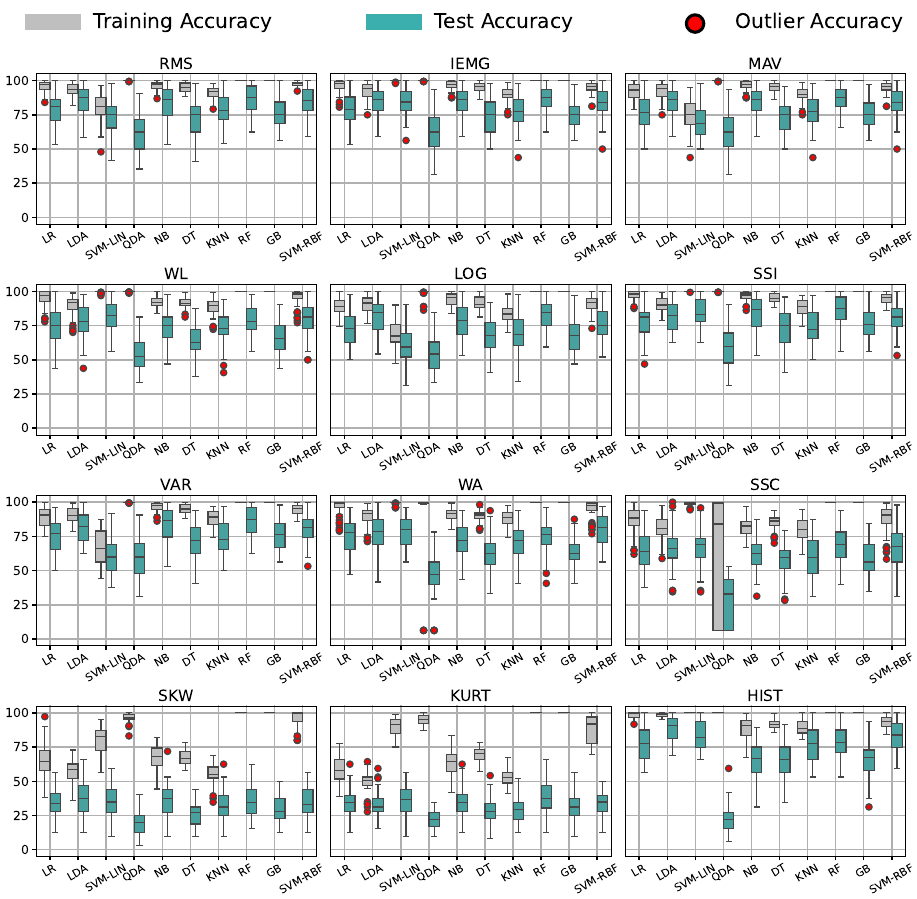
Figure 8. Distribution of accuracy for all feature–model pairs for the grasp label group on all participants’ data from the first